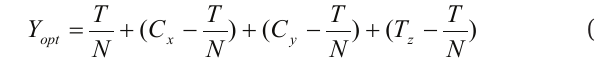
(WO ) plates via precipitation procedure using OA 2 4 3